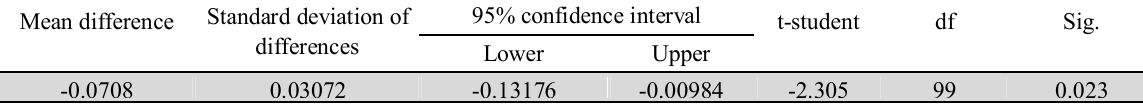
The summary of testing the main hypothesis of this survey on difference between Bass and EFQM Mean difference Standard deviation of